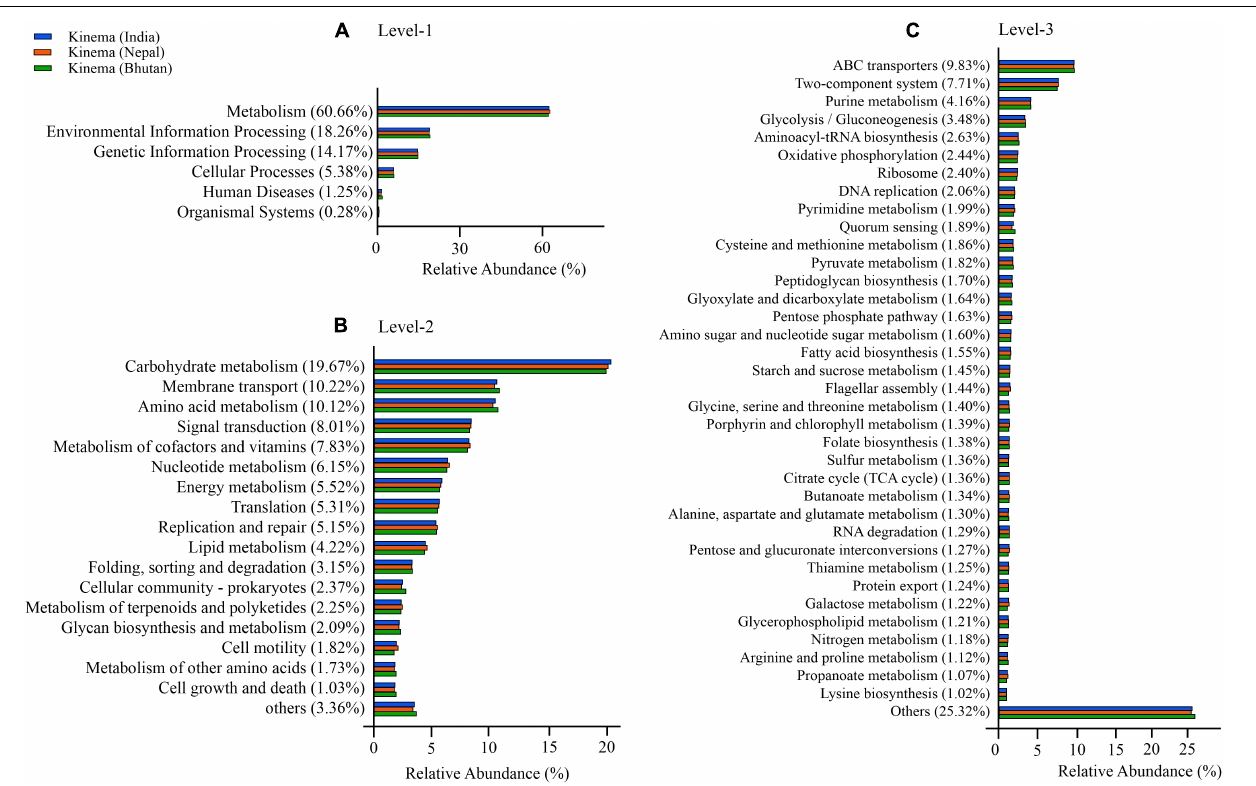
FIGURE 5 | Predictive functional features mapped against Kyoto Encyclopedia of Genes and Genomes (KEGG) database were represented by relative abundance (%) at three different categories: (A) Level 1, (B) level 2, and (C) level 3. The functional features with less than 1% were grouped as